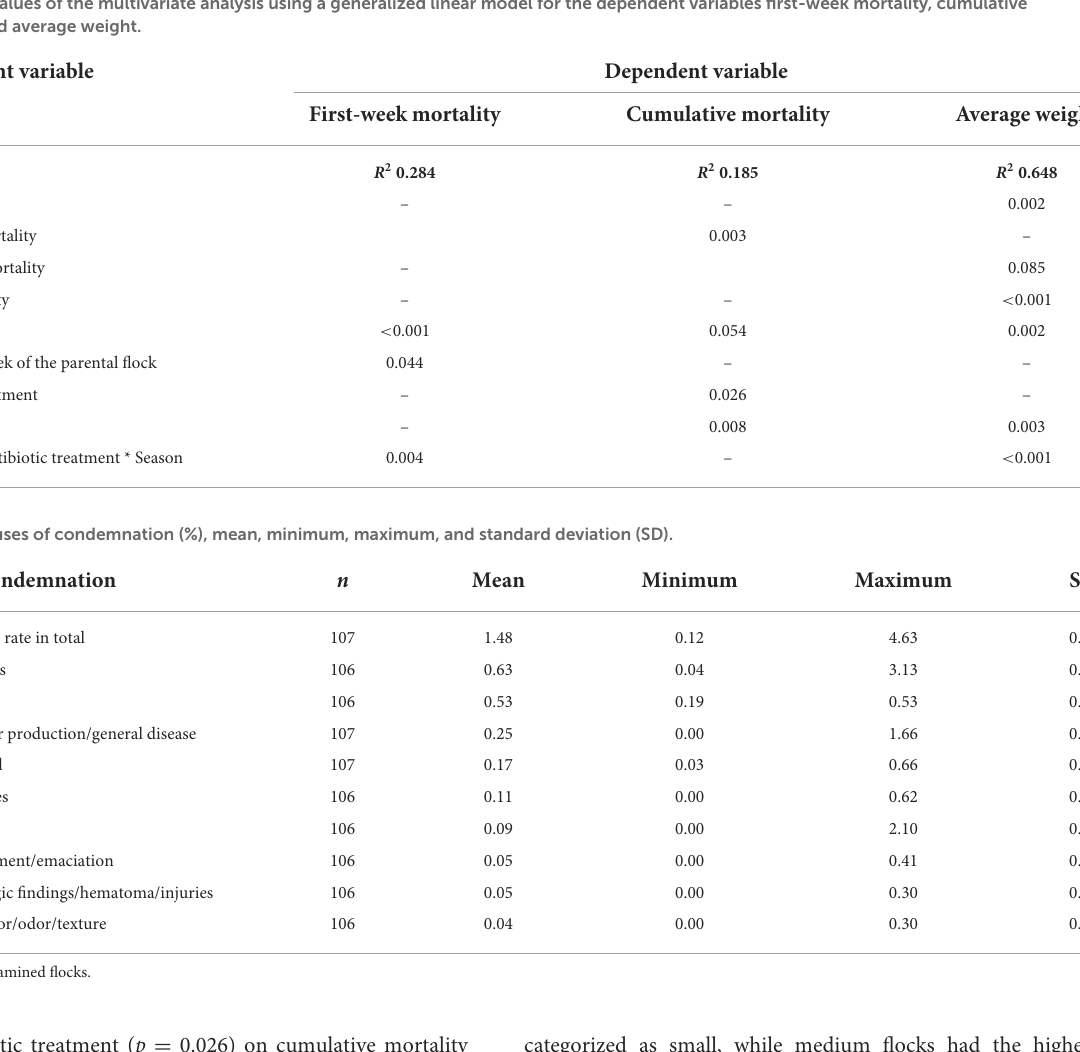
TABLE 2 P -values of the multivariate analysis using a generalized linear model for the dependent variables first-week mortality, cumulative mortality, and average weight.